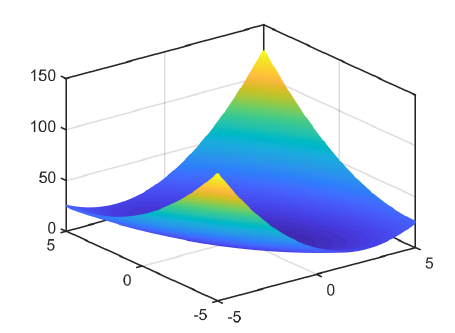
Figure 6. The figure of function f 4 .